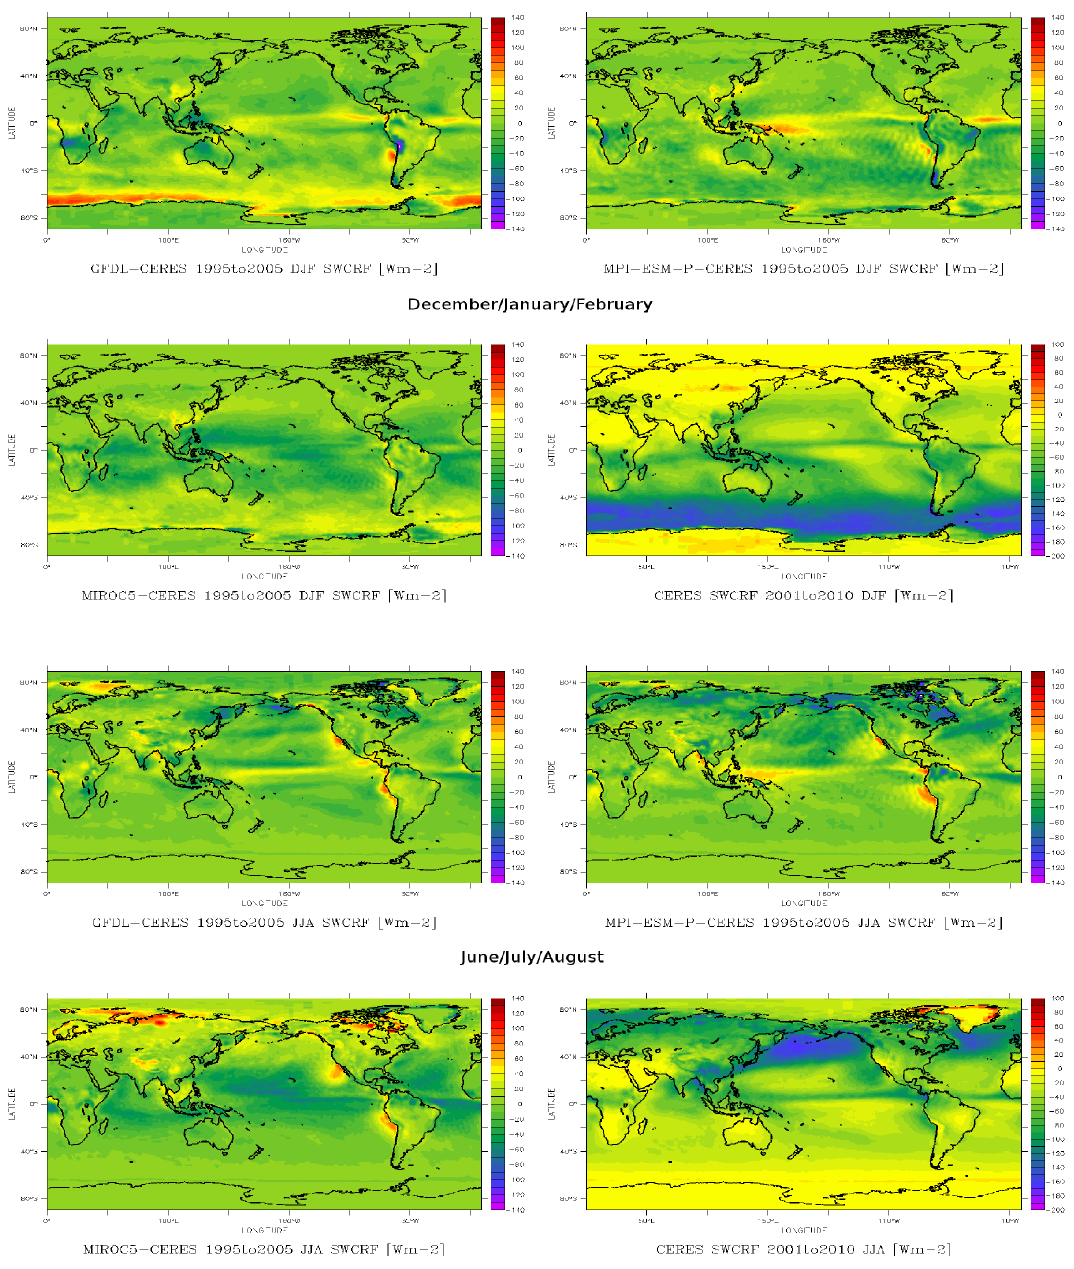
Figure 6. Seasonal plots showing differences between CMIP5 and CERES for SWCRF for 10 years for MPI-ESM-P, MIROC5, and GFDL. The upper panel shows DJF, lower panel JJA. Plots show results given in Wm − 2